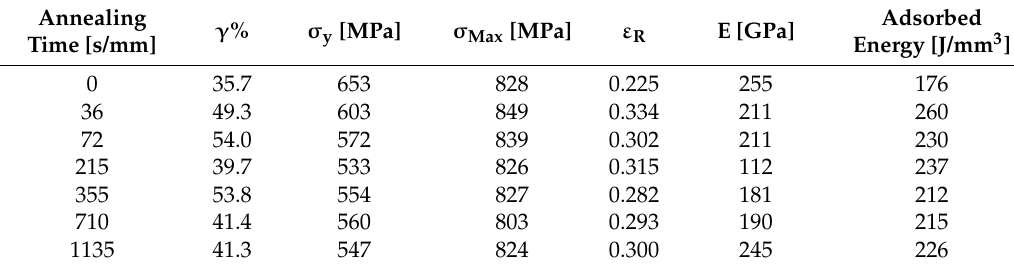
Table 4. UNS S32760 tensile test results: the specimen annealed thermal treated at 1353 K (1080 ◦ C) for 36 s/mm holding time show the best combination of elastic and plastic